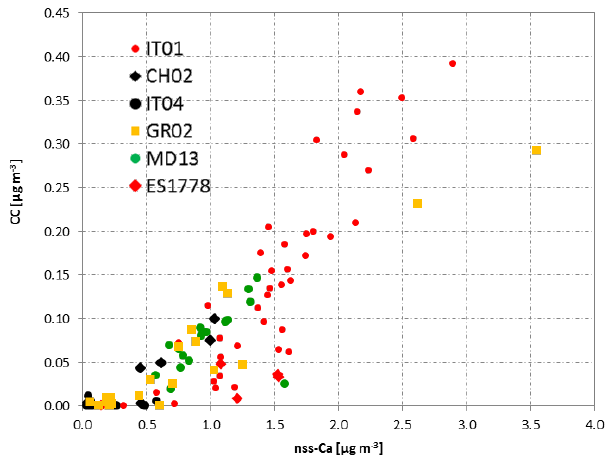
Figure 5. Cross correlation plot between carbonate carbon (CC) and nssCa content (in µgm − 3 ) in PM 10 at sites in different